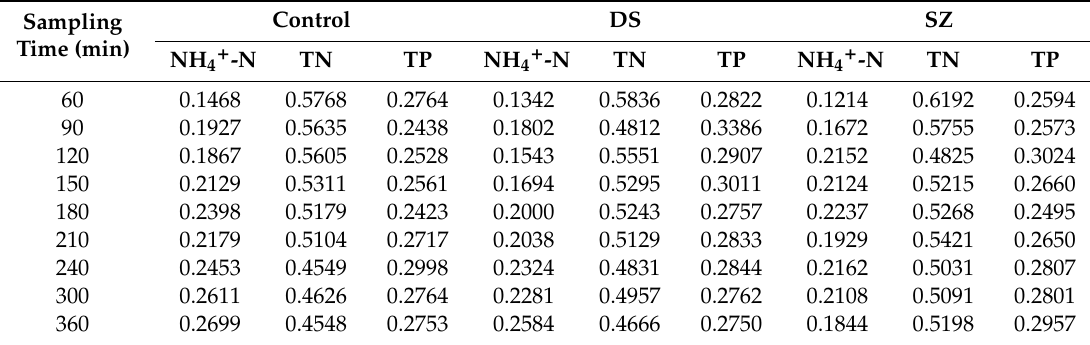
Table 5. The weights of the pollution factors in water samples.